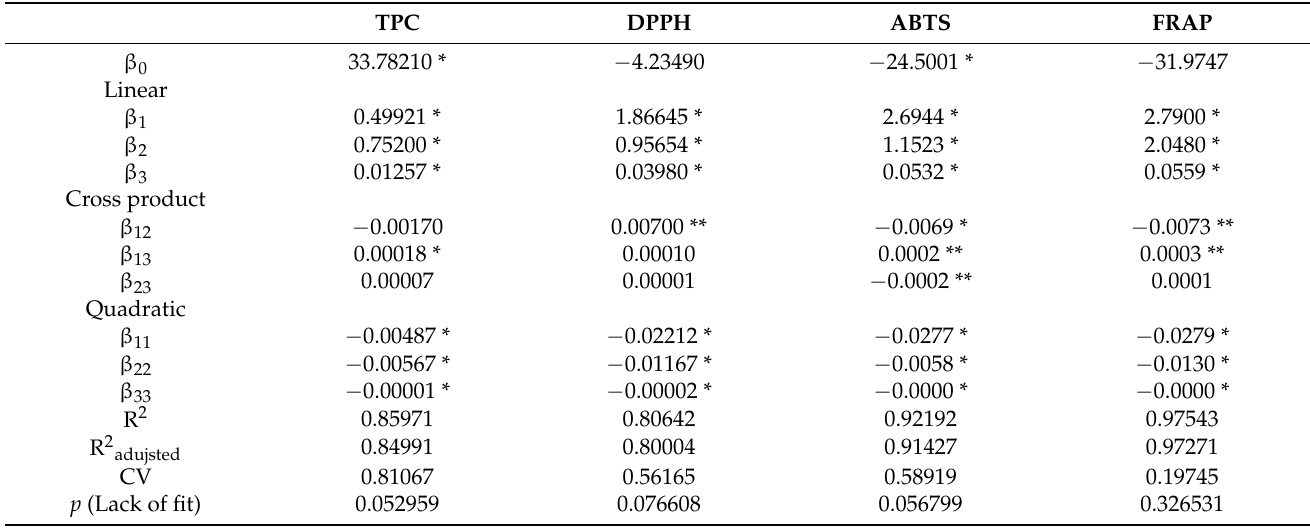
Table 2. Regression coefficients and analysis of variance (ANOVA) of the model for the response